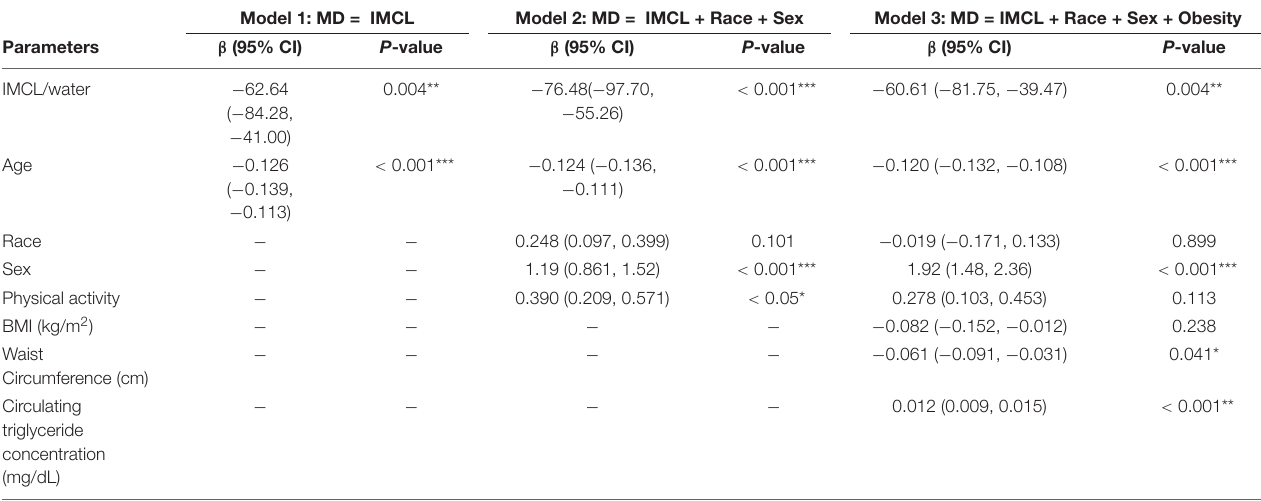
TABLE 2 | Multivariate analysis adjusting for confounding variables.